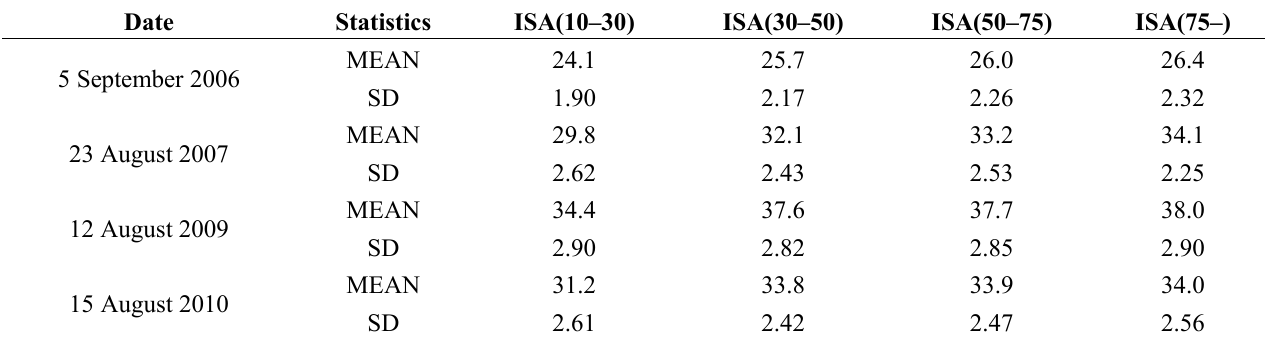
Table 6. Descriptive statistics of LST (in °C) derived from Landsat TM images over categories of percent impervious surface area.